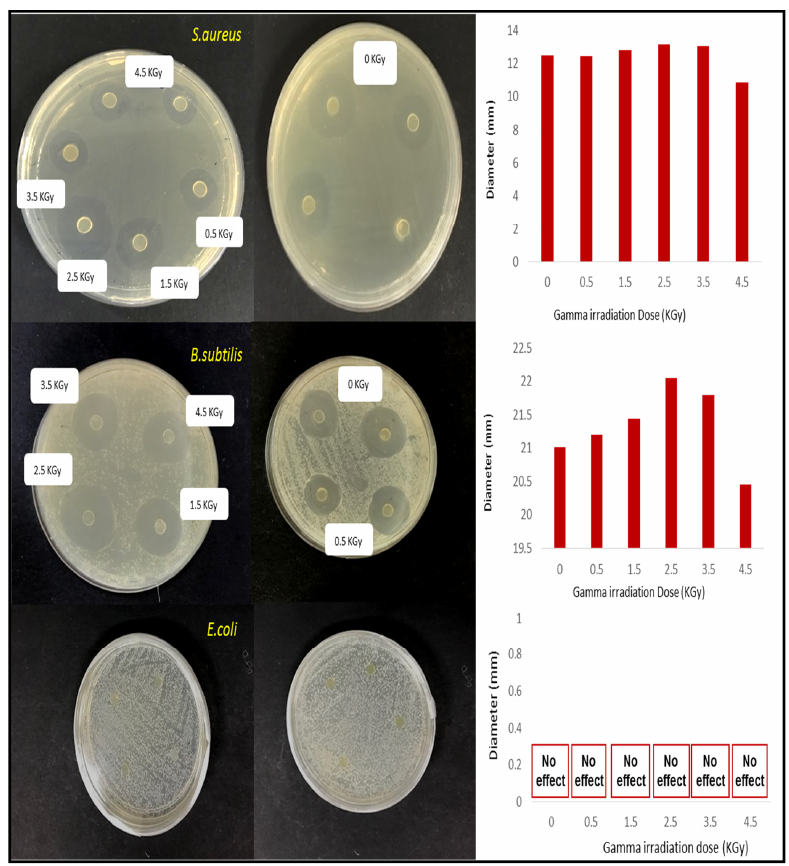
Figure 9. Inhibition zone measurement results (photographic images and diameter statistics of inhibition zone) of seaweed-neem composite films under the various radiation doses against Staphylococcus aureus , Escherichia coli , and Bacillus subtilis.